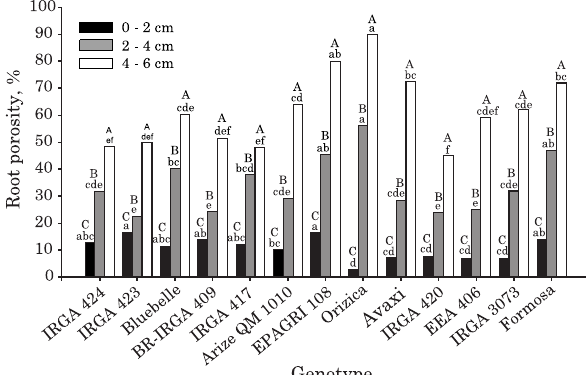
Figure 1. Porosity in three segments of adventitious roots of rice genotypes obtained in hypoxia. Lowercase letters compare genotypes for each